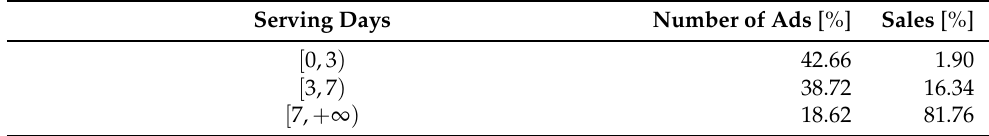
Table 3. Percentage of the number of ads served and their sales on the serving date. While 80% of the ads were discontinued within a week of serving, the 20% of the ads that were served for more than a week accounted for 80% of the sales. Serving